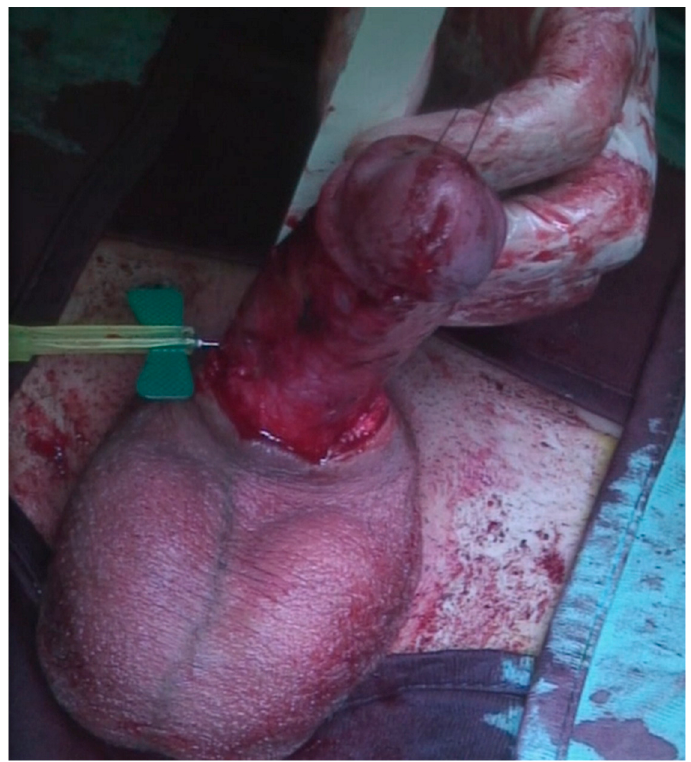
Figure 4. The defect was measured in length and girth.